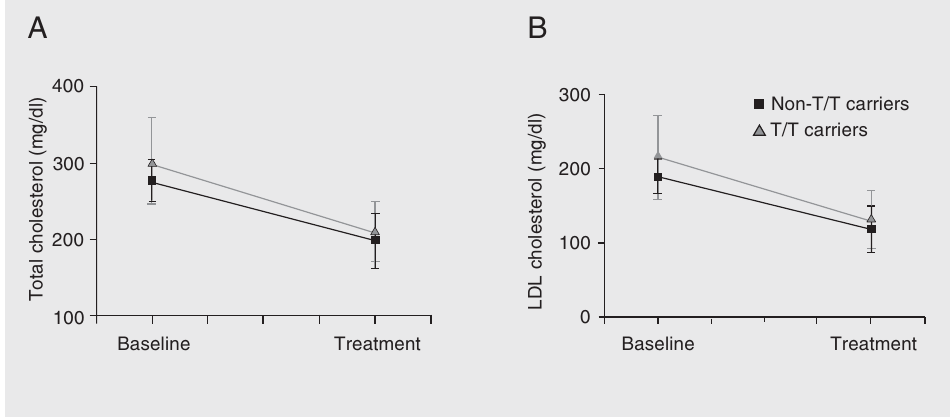
Figure 2. Serum concentration of total (A) and low-density lipo- protein (LDL) cholesterol (B) in Brazilian hypercholesterolemic individuals of European descent according to MDR1 haplotype, before (baseline) and after ator- vastatin therapy (10 mg/day).